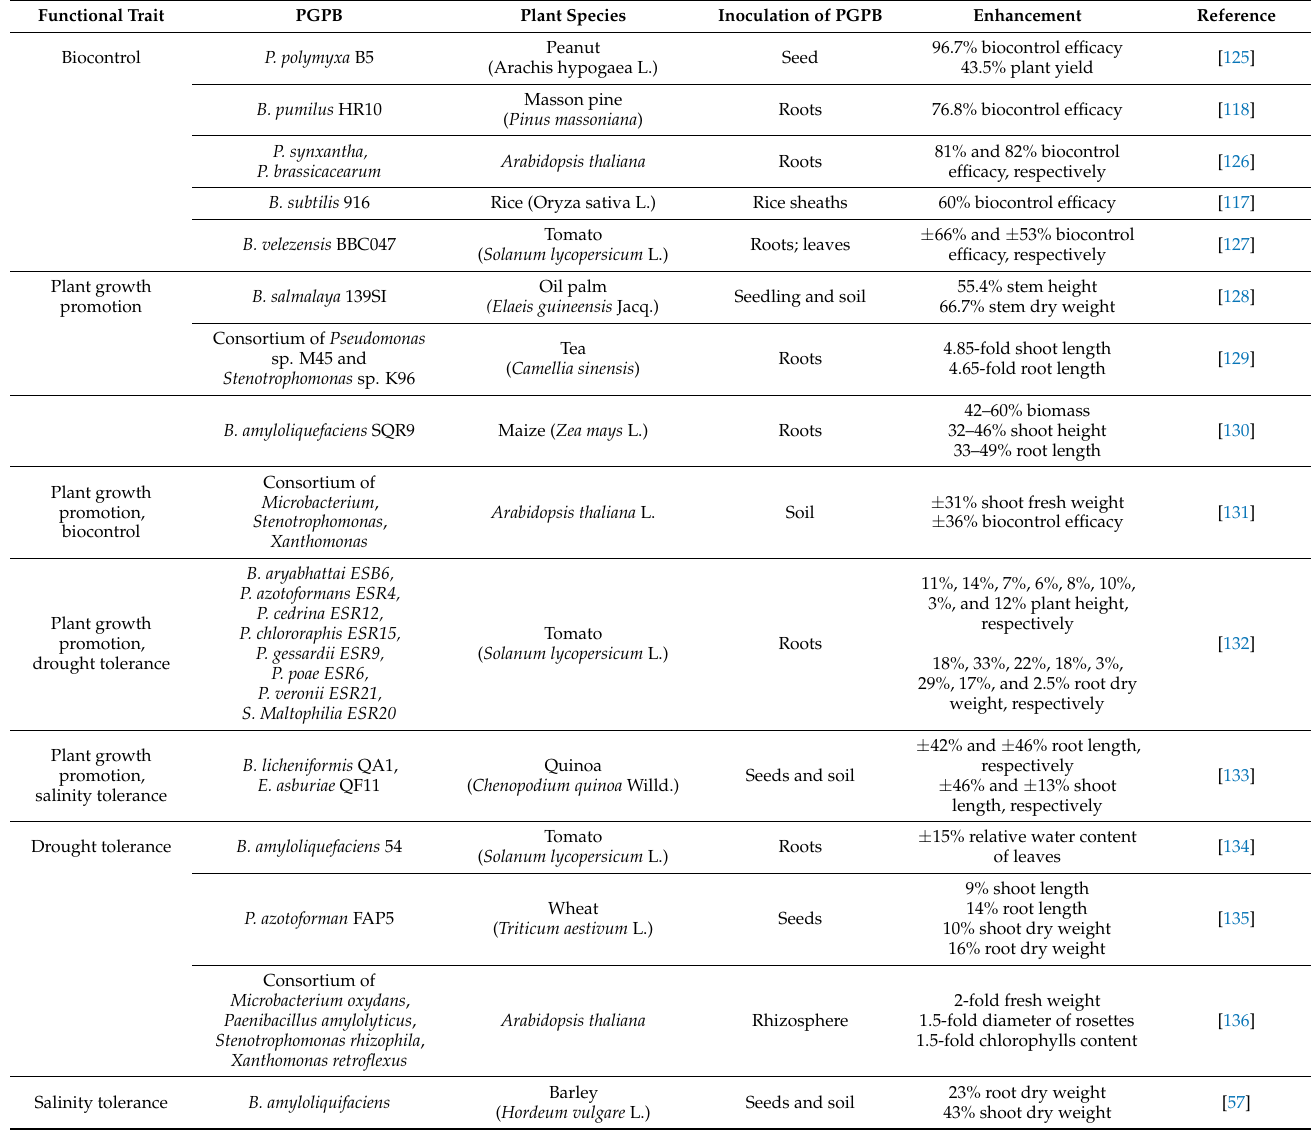
Table 1. Role of PGPB biofilms associated with various plant